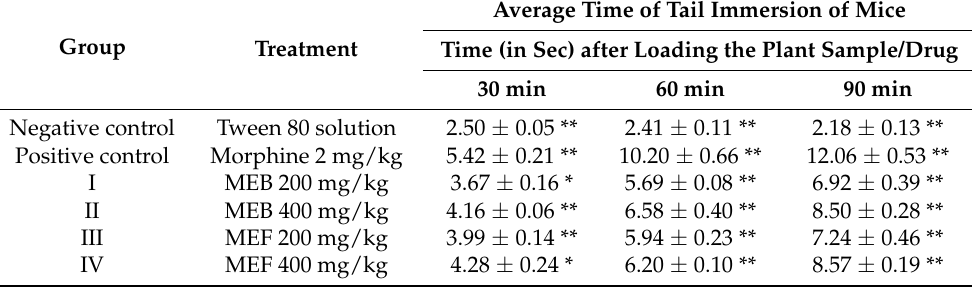
Table 4. Central analgesic effect of methanolic extract of bark (MEB) and methanolic extract of fruit coat (MEF) of W. coccinea in mice by tail immersion method.